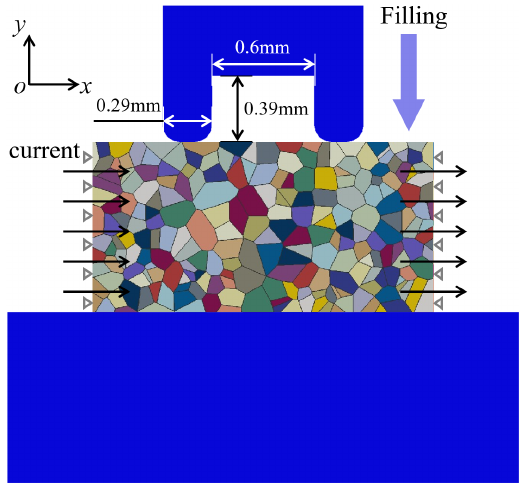
Figure 5. Polycrystal models of SUS304 stainless steel with different grain sizes: ( a ) 95 μ m; ( b ) 18.81 μ m.